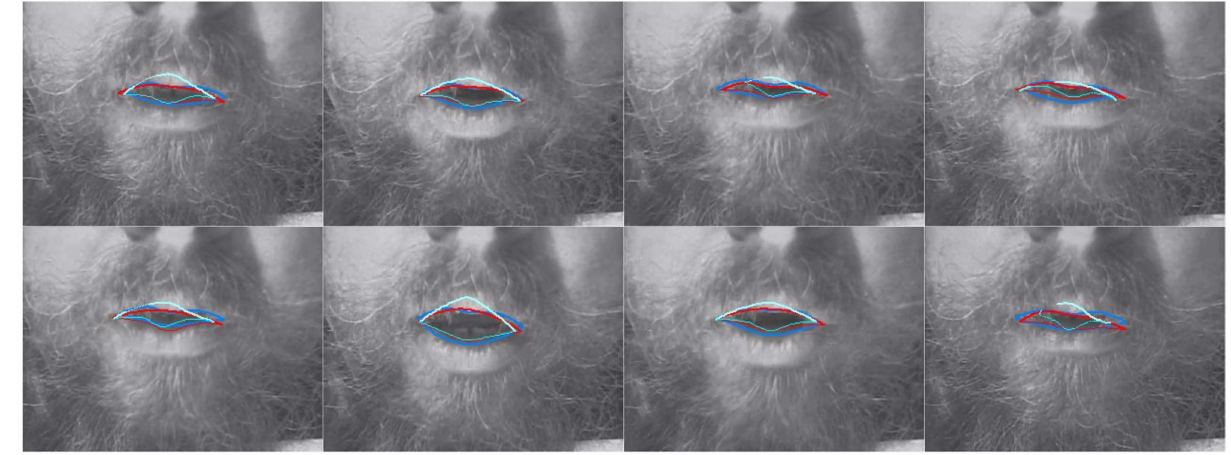
Figure 18. Speaker 17ms; blue—hand-label; red—MobileNetV2; cyan—ResNet50.